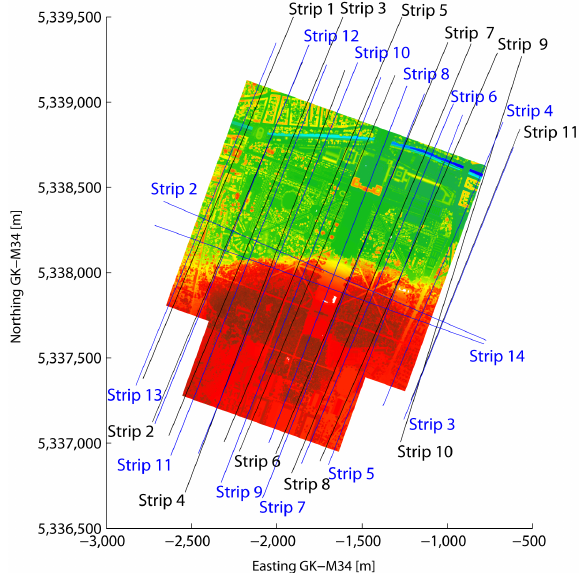
Figure 2: Digital surface model of the Sch¨onbrunn area of Vienna overlaid with the flight trajectories of the two scanning campaigns of 2004 (black lines) and 2005 (blue